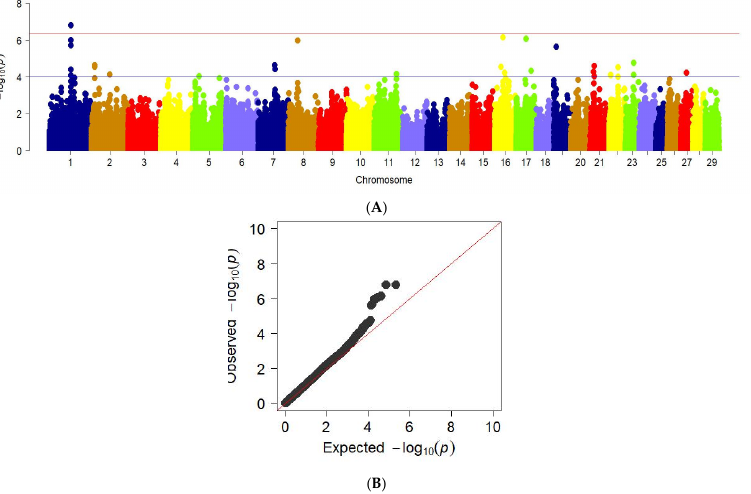
Figure 6. Manhattan plots of WGS for chest girth with significance thresholds indicated at − log 10 p > 4.5 × 10 − 7 . B The quantile-quantile (QQ) plots for the studied quality trait. Panel ( A ) shows the chromosome regions associated with chest girth using ~150,000 imputed sequence SNPs. The panels ( B ) have shown the QQ plots for the chest girth trait. Analysis of genome-wide associations with ball output demonstrates the following regions in chromosomes 1, 2, 3, 6, 7, 9, 11, 18, 20, and 29. This is shown in the Manhattan graph (Figure 7a). The data is confirmed by the QQ graph for this feature.